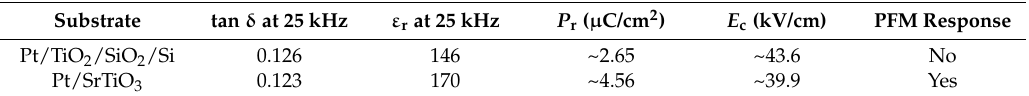
Table 1. Room-temperature electrical characteristics of KNN films deposited on platinized Si and SrTiO 3 substrates, including the dissipation factor (tan δ ), the relative dielectric permittivity ( ε r ) at 25 kHz, the remanent polarization ( P r ) and the coercive field ( E c ) at applied electric field of ~70 kV/cm, as well as presence of out-of-plane piezoelectric force microscopy (PFM) response. Substrate tan δ at 25 kHz ε r at 25 kHz P r ( µ C/cm 2 ) E c (kV/cm) PFM Response Pt/TiO 2 /SiO 2 /Si 0.126 146 ~2.65 ~43.6 No Pt/SrTiO 3 0.123 170 ~4.56 ~39.9 Yes